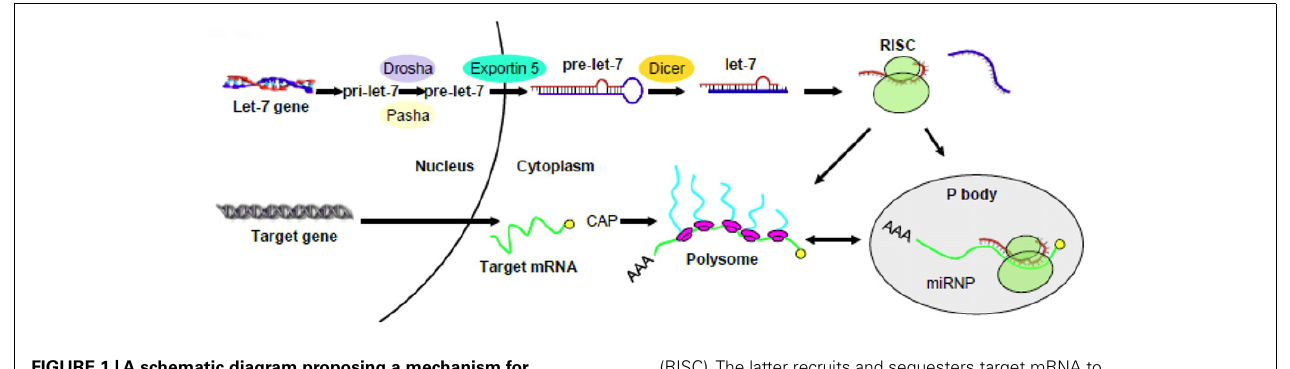
FIGURE 1 |A schematic diagram proposing a mechanism for the regulation of target gene by let-7. Pri- and pre-let-7 are produced and exported into the cytosol where the mature let-7 was incorporated into the RNA-induced silencing complex